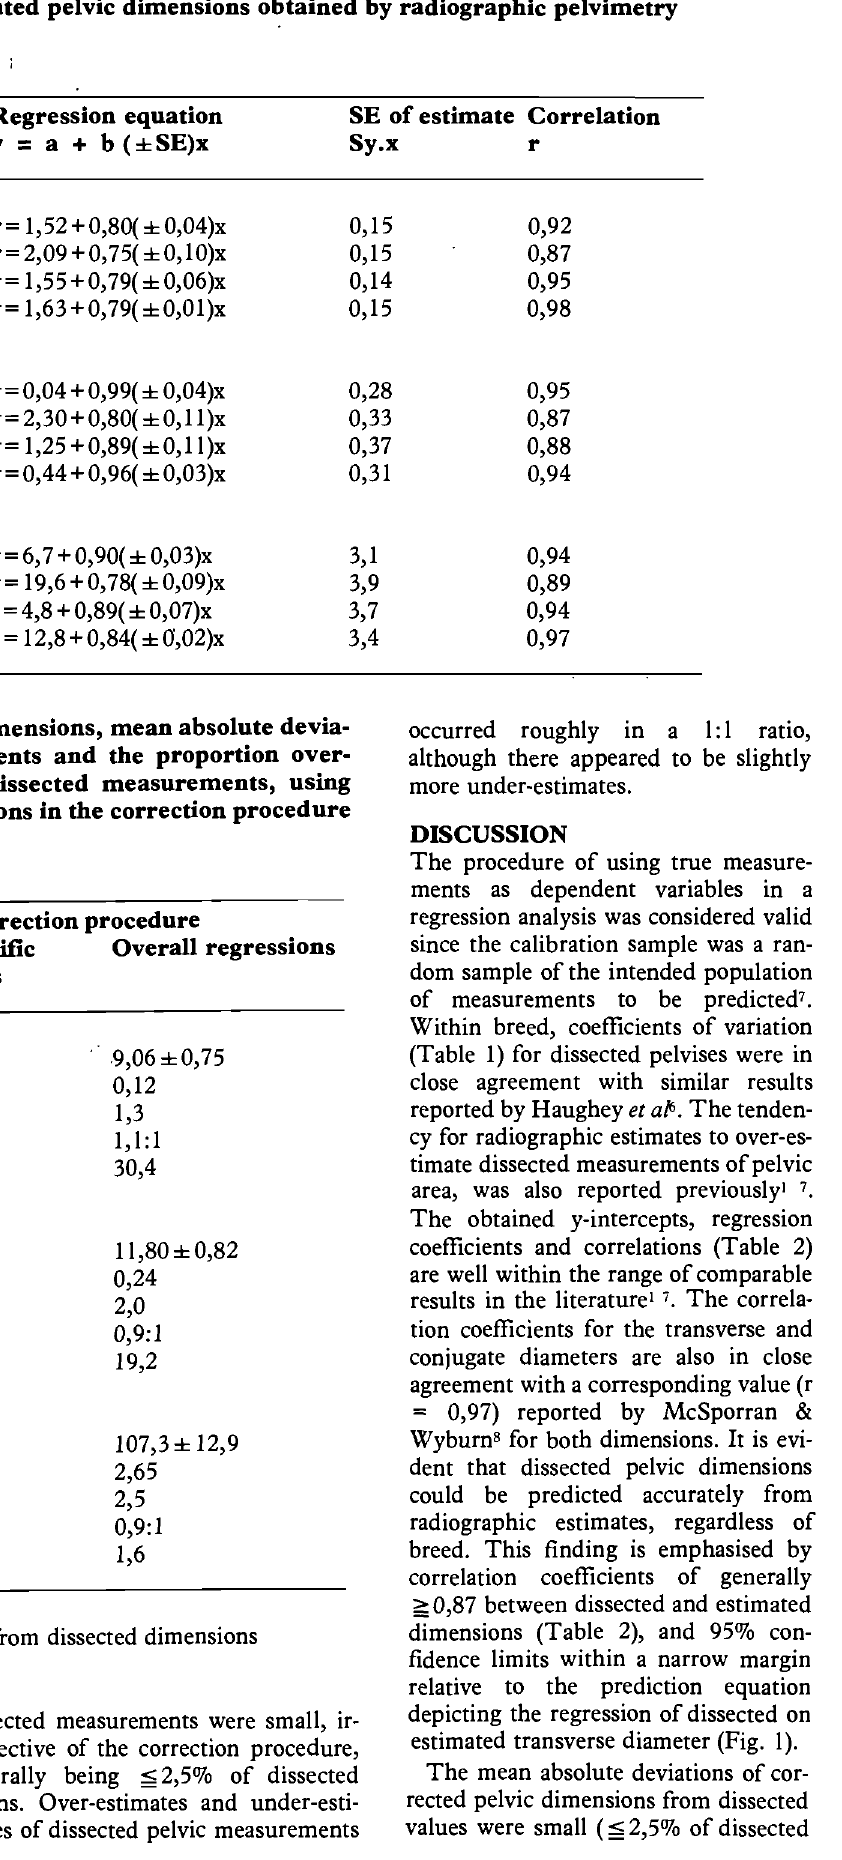
dissected measurements were small, ir respective of the correction procedure, generally being ~ 2,5% of dissected means. Over-estimates and under-esti mates of dissected pelvic